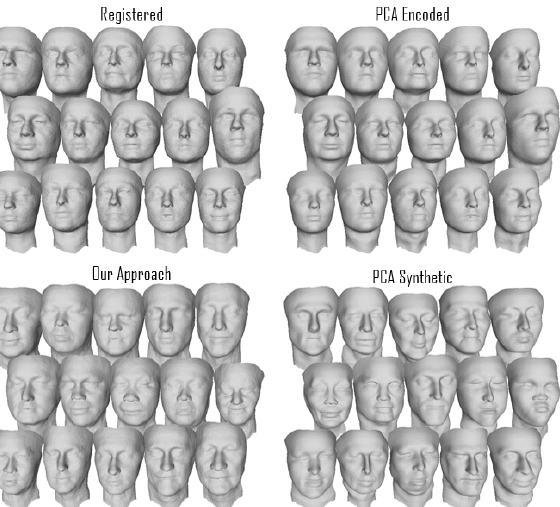
Figure 5. Example of facial scans (without selection). A batch of registered scans ( top left ), the same scans encoded ( top right ), synthetic scans generated with our approach ( bottom left ), and PCA synthetic scans ( bottom right ).